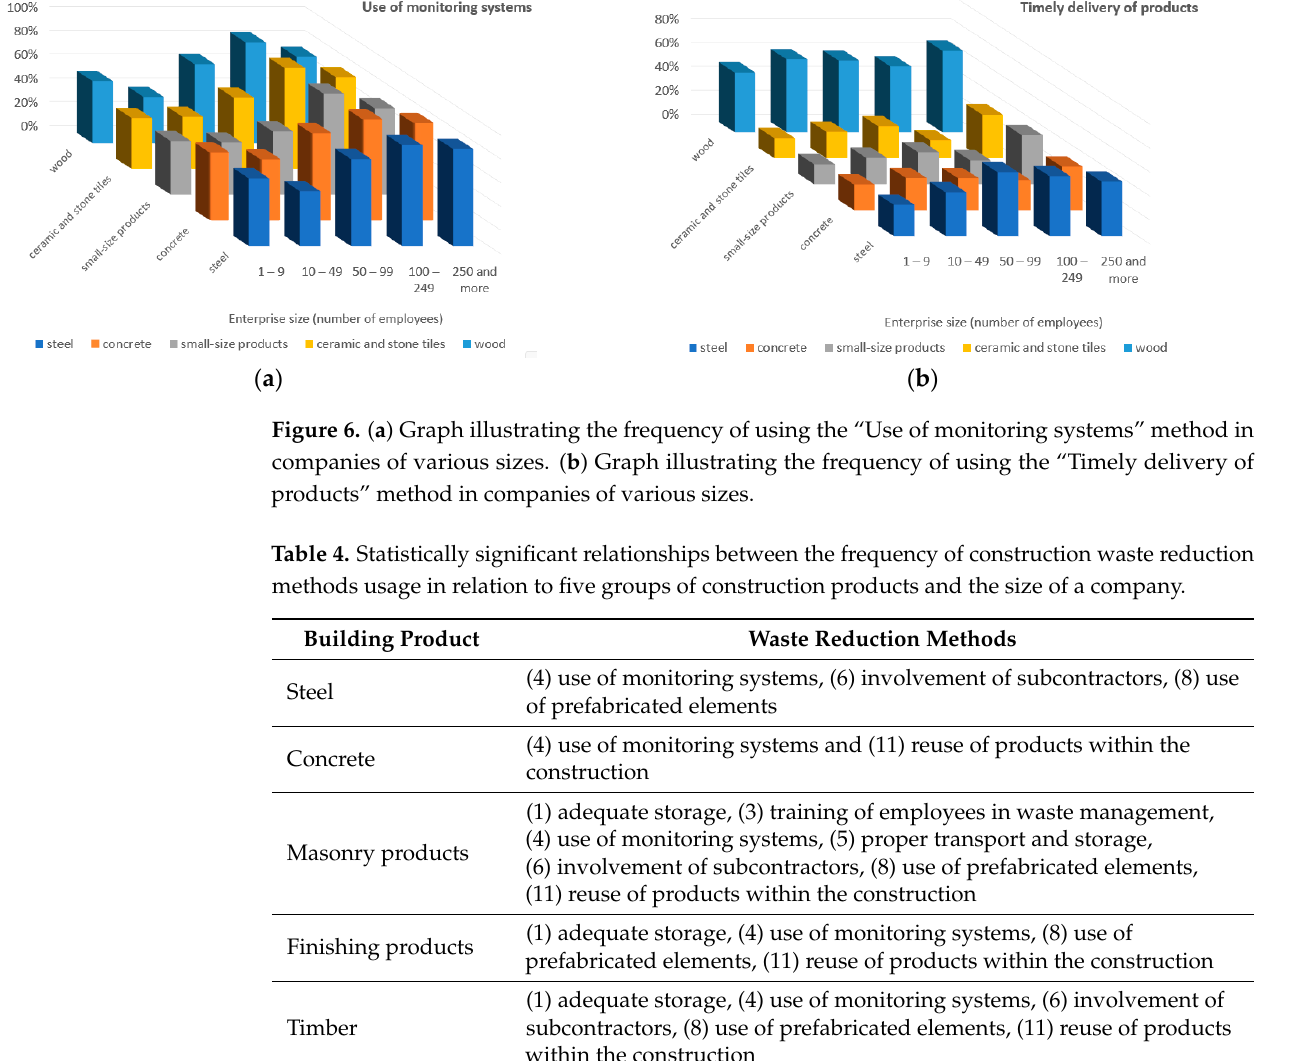
Figure 6. ( a ) Graph illustrating the frequency of using the “Use of monitoring systems” method in